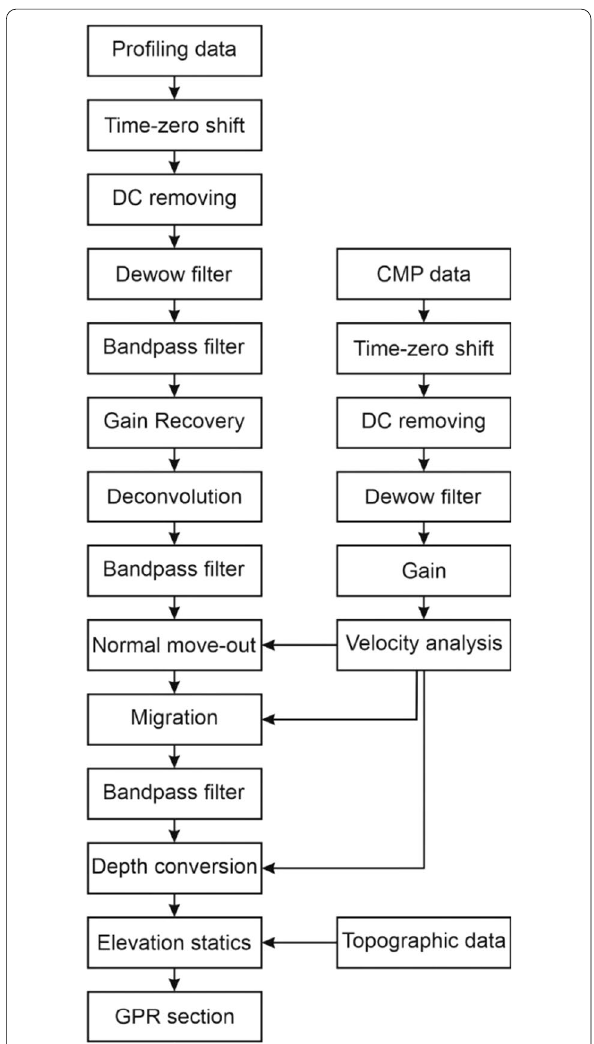
Fig. 3 Flowchart of GPR data